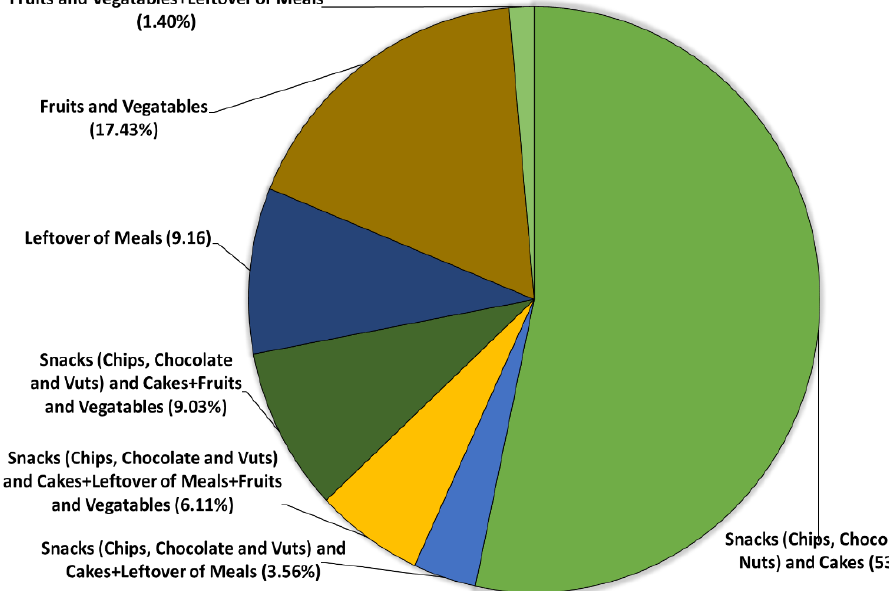
Figure 2. The snack preferences of participants during the COVID-19 pandemic.